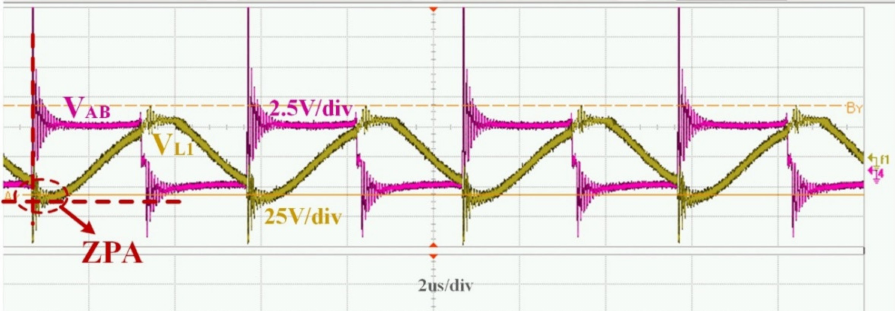
Figure 36. Inverter output voltage V AB and transmitter coil voltage V L1 when ZPA.